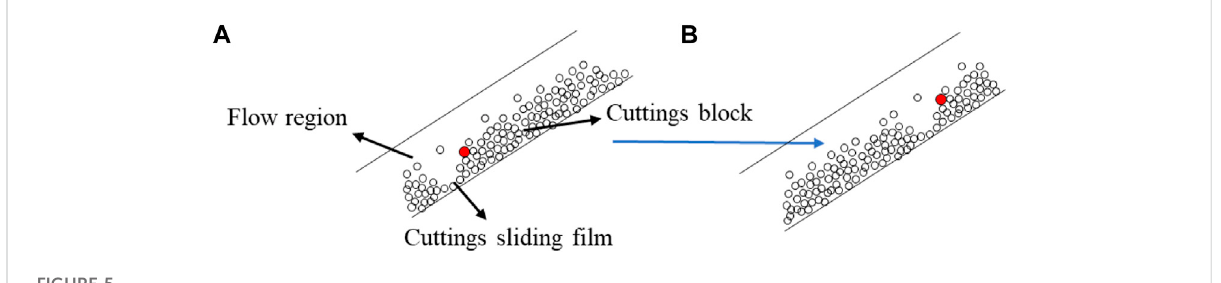
FIGURE 5 Original segment model.